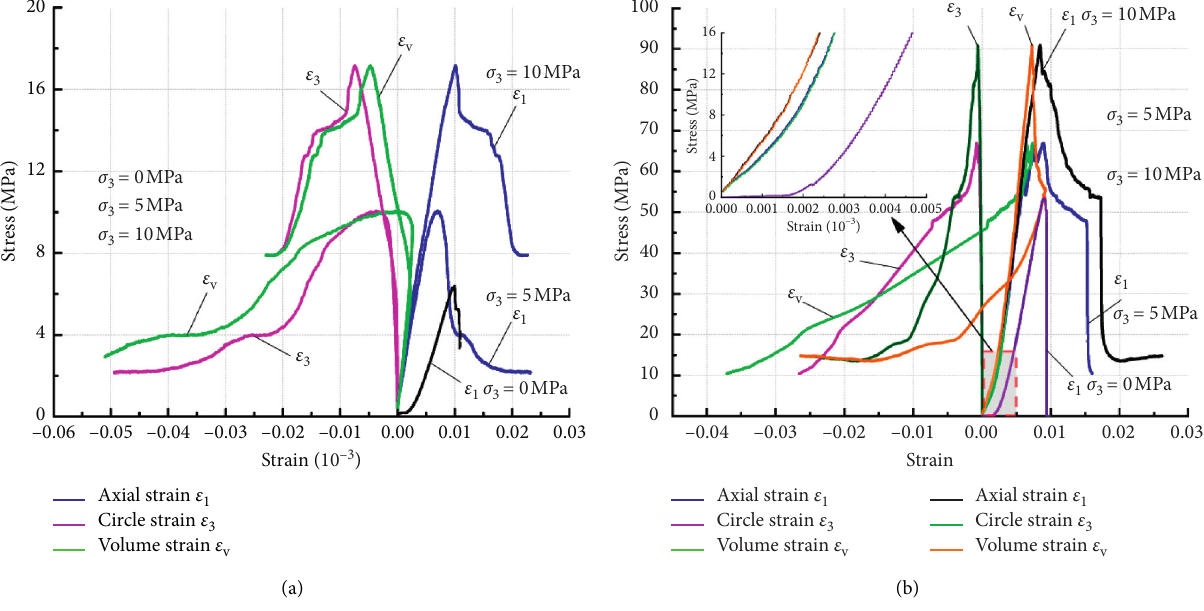
Figure 5: Stress-strain curves of (a) pure coal samples and (b) pure rock samples under different confining pressures.